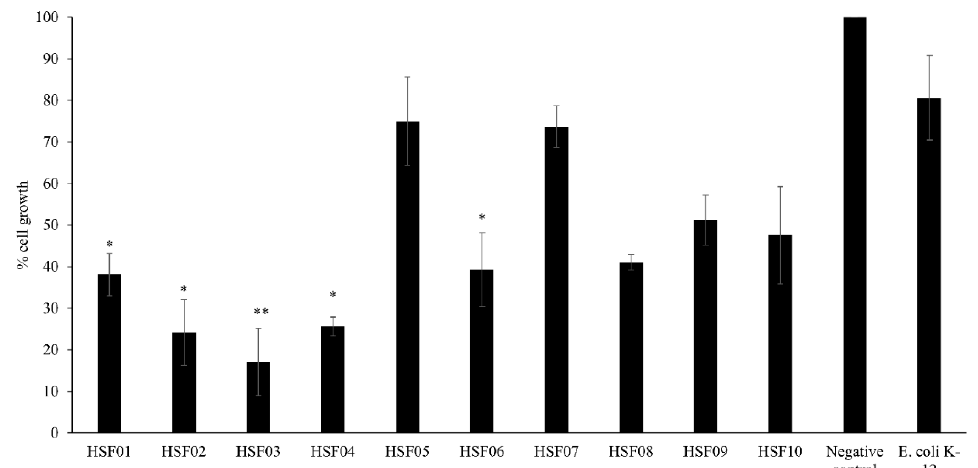
Figure 1. The growth inhibition effect of conditioned media prepared from bacteria isolated from the fecal samples of the scorpion H. spinifer . The results represent mean ± standard error of three sets of experiments performed in duplicate for HeLa cells; p value was determined using two sample T-test, two-tailed distribution, (*) is <0.05 and (**) is <0.005.